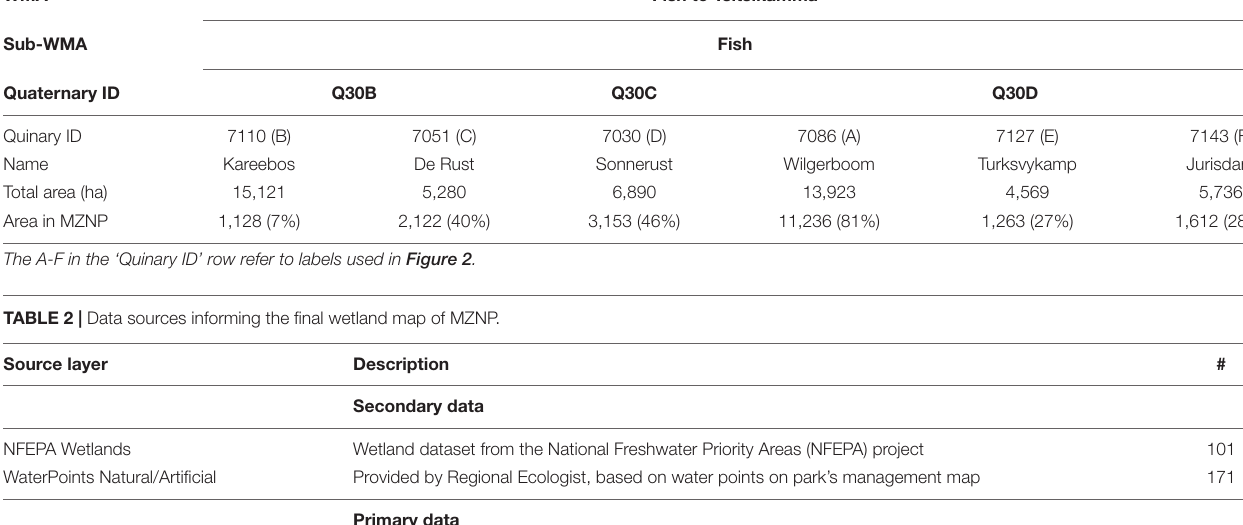
TABLE 1 | Mountain Zebra National Park catchments. WMA